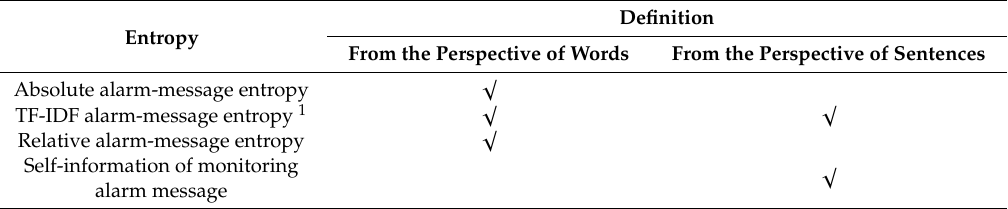
Table 1. Definitions of di ff erent alarm message